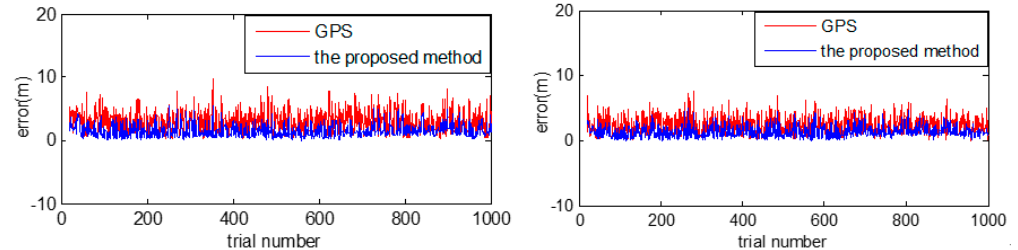
Figure 12. Localization errors from the proposed method.